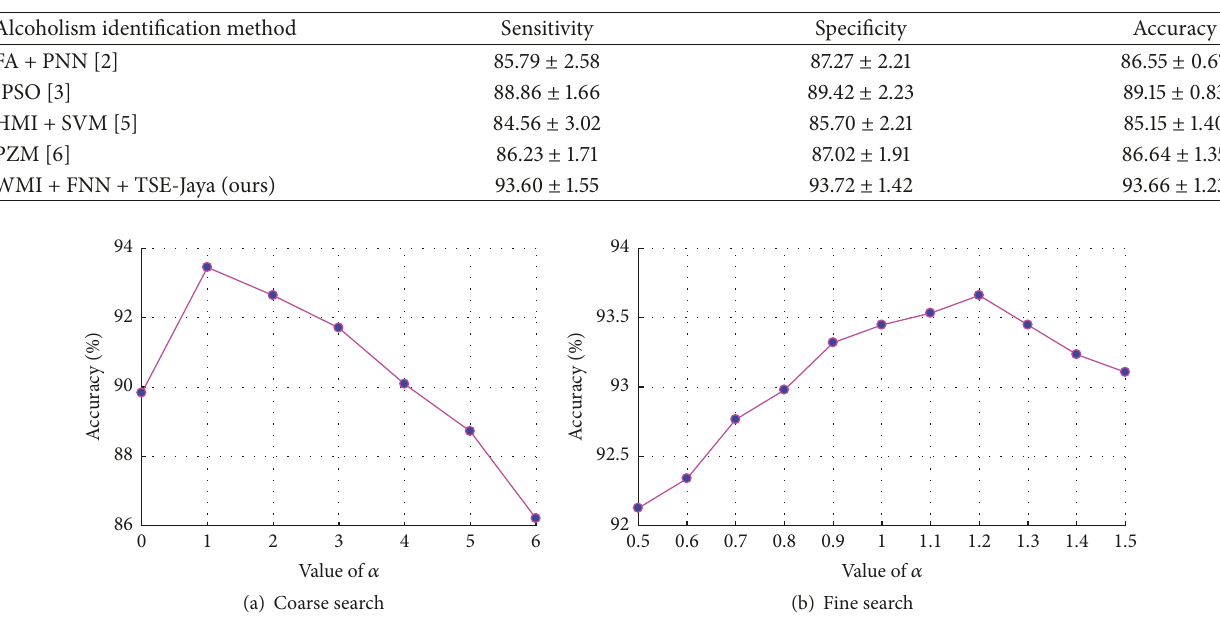
Figure 9: Choosing the optimal Renyi order by coarse-to-fine grid search.